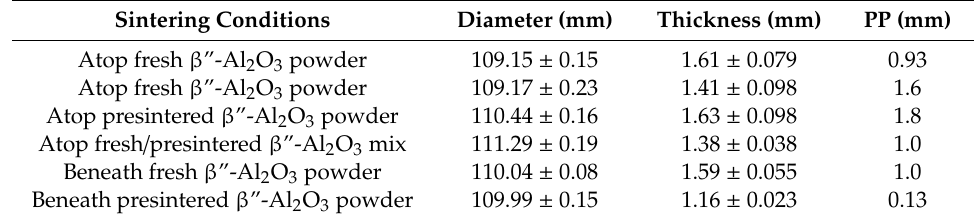
Table 1. E ff ect of sintering conditions on Na- β ”-Al 2 O 3 ceramic disc dimensions. Diameter is expressed as the average of four measurements made at 0, 45, 90, and 135 ◦ . The error value is half of the di ff erence between the maximum and minimum measured value and provides a roundness tolerance. Thickness is expressed as the average of five measurements made with a digital micrometer. The error value is half of the di ff erence between the maximum and minimum measured value. Plane parallelism (PP) is expressed as the di ff erence between the sample thickness and the maximum measured displacement from the top surface of the sample to the flat reference surface